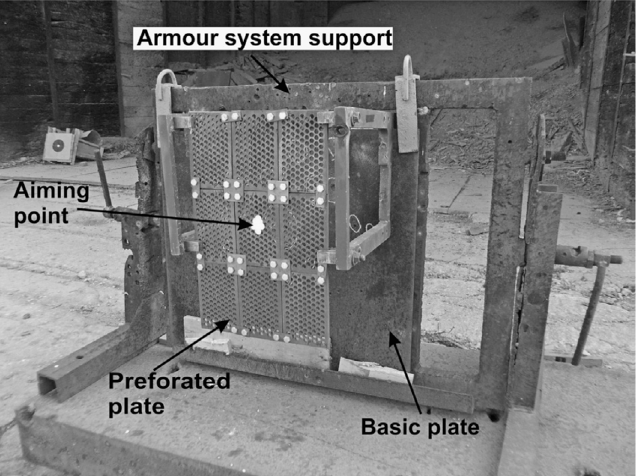
Figure 6. Test setup with the austempered ductile iron (ADI) material perforated plate made of nine smaller perforated plates joined by bolts [37]. Reprinted with permission from Elsevier: Mater. Des. ,